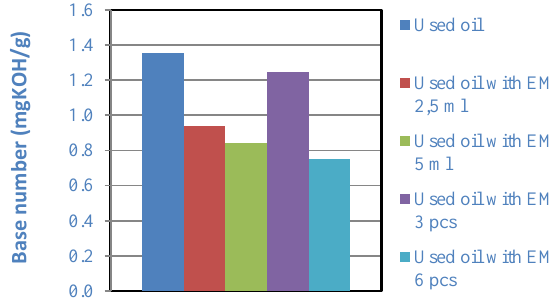
Fig. 3. Base number of used oil and used oil with EM in liquid form and ceramic tubes